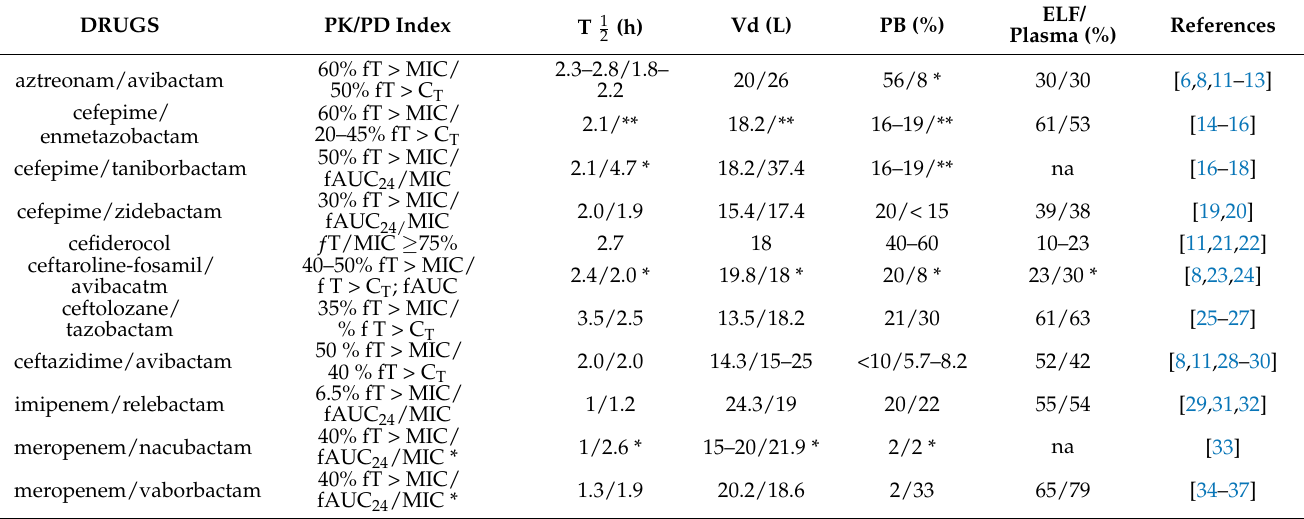
Table 3. Pharmacokinetic parameters of β -lactams/ β -lactamase inhibitors and cefiderocol. The con- centrations of β -lactams and β -lactamase inhibitors were determined using liquid chromatography– tandem mass